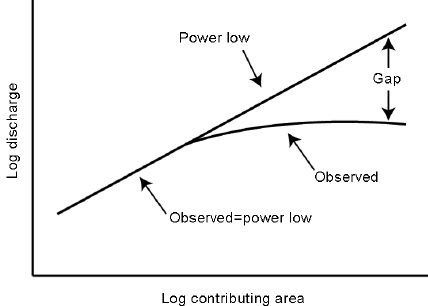
Figure 8. Conceptual diagram of the characteristic concave-down shape of the FEC (observed) shown in comparison to a power-law function between Q p and contributing area. The “gap” between the observed curve and the predicted power law is caused by precipi- tation limitations and mechanisms occurring during the routing of water over the